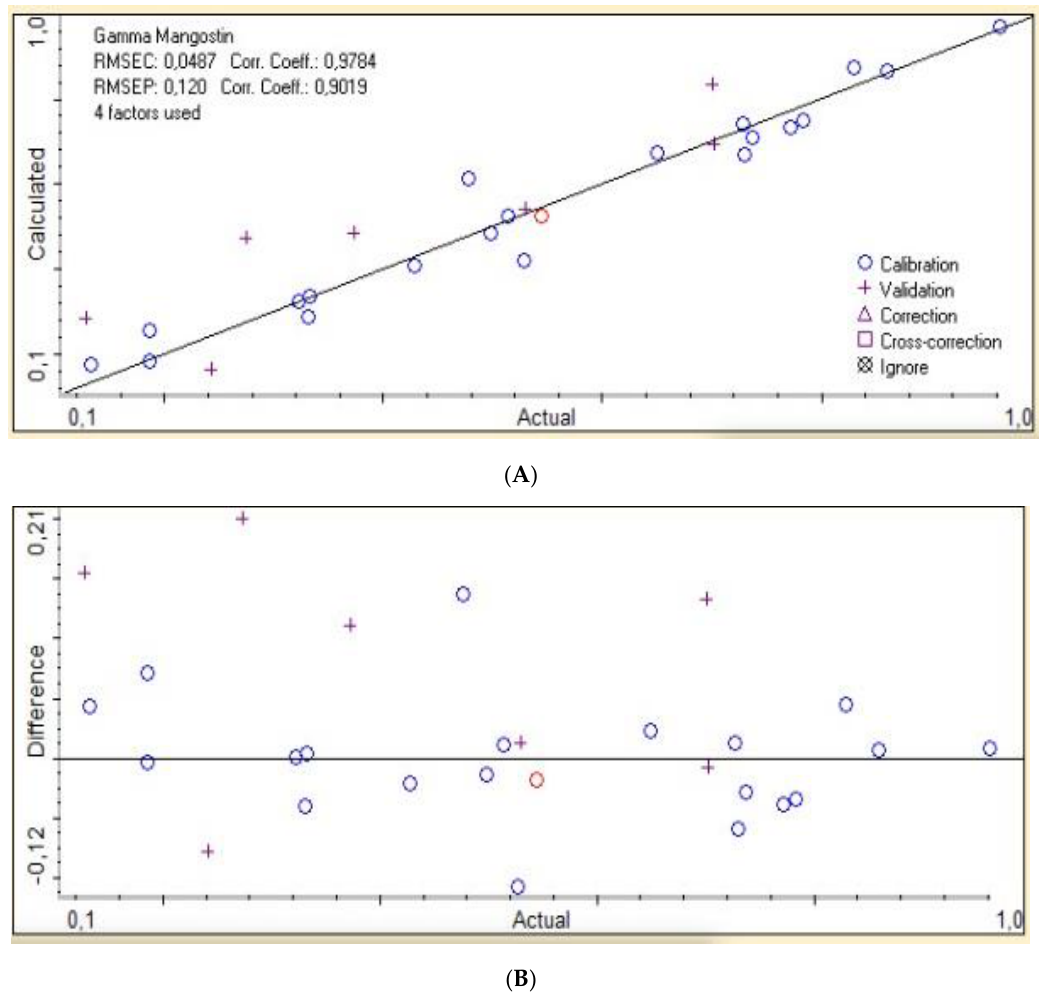
Figure 4. The Partial Least Square regression (PLSR) between actual values of γ-mangostin combined with wavenumbers region 3700–2700 cm −1 using the second derivative FTIR ( A ), along with residual analysis ( B ) .